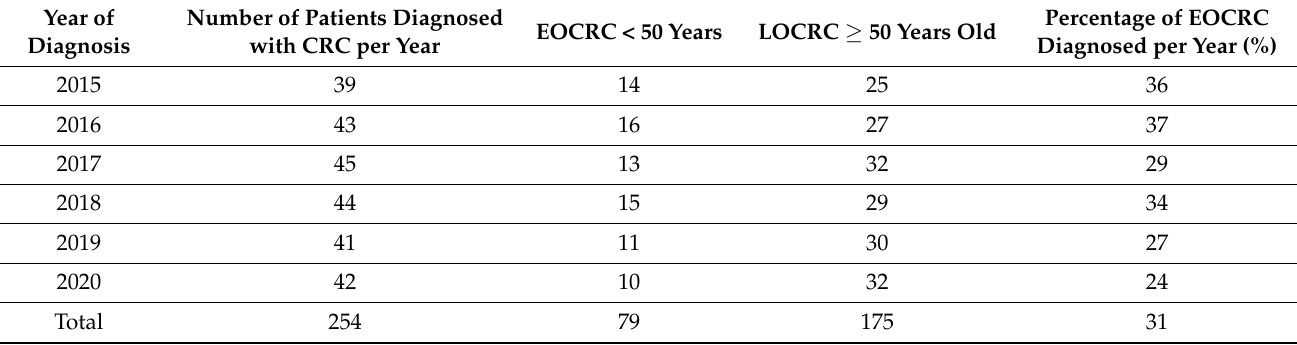
Table 1. The proportion of EOCRC to LOCRC per year.